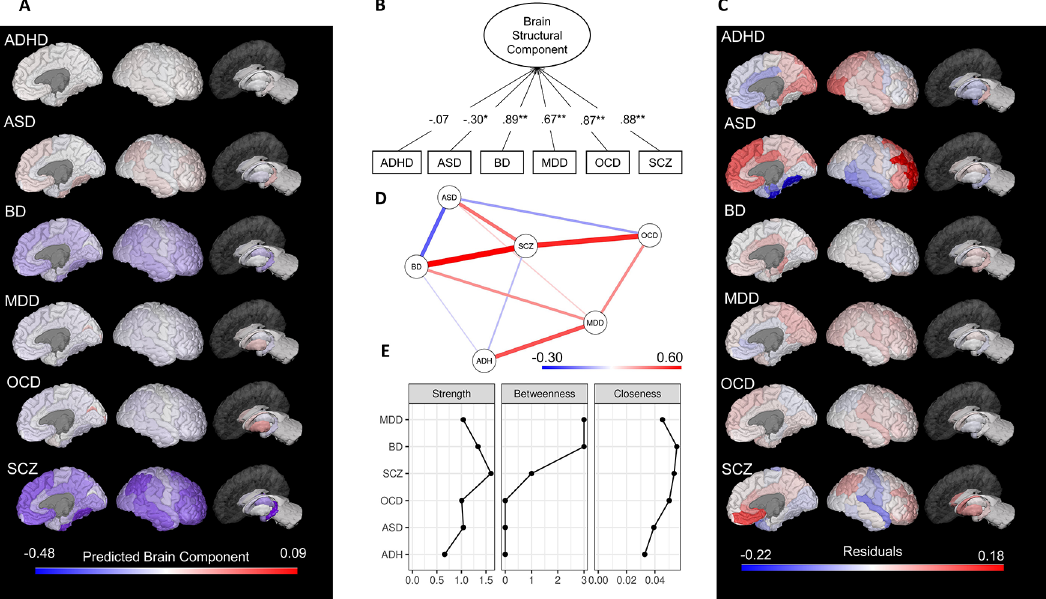
Figure 2. Principal component and network analysis of the effect sizes of brain structural alterations in six psychiatric disorders. (A) Predicted component scores mapped onto brain regions; (B) Path diagram of the principal component unidimensional solution, with number depicting component loadings; (C) Residuals from the regional effect sizes accounting for the predicted shared principal component. As in Opel et al. , 2 the absolute size of residuals encompasses the degree of representation through the shared unidimensional component. Lower (negative) residuals represent underestimation and higher (positive) residuals represent overestimation based on the brain-regional shared variance. (D) gLASSO correlations network of brain structural alterations in the six psychiatric disorders. Edges represent parsimonious partial-correlations between psychiatric disorders. A stronger correlation (positive = blue; negative = red) results in a thicker and darker edge. (E) Network centrality measures. ADHD, attention-deficit/hyperactivity disorder; ASD, autism spectrum disorder; BD, bipolar disorder; MDD, major depressive disorder; OCD, obsessive-compulsive disorder; SCZ, schizophrenia. All effect sizes used in these results are taken from Opel et al. 2 * p < 0.05; ** p < 0.001.